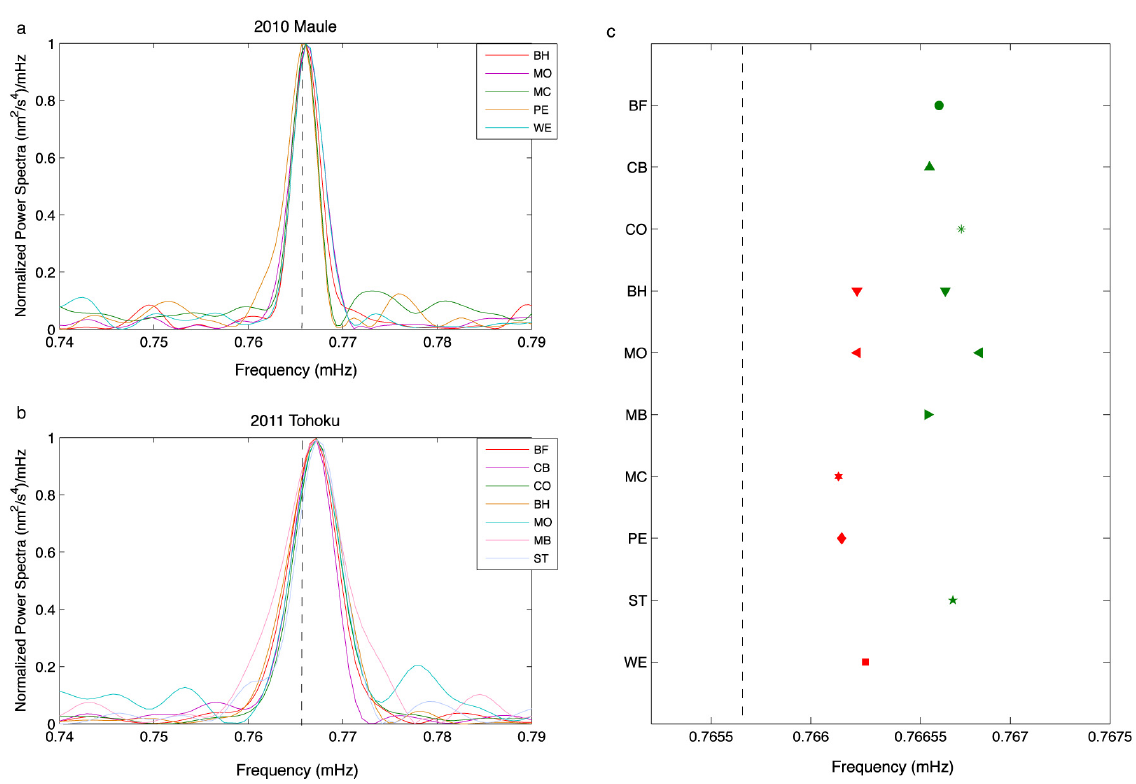
T . (a) The results of 5 residual gravity time series after the 2010 Maule event; (b) the results of 7 residual grav- Figure 10. The power spectra of 0 4 ity time series after the 2011 Tohoku; (c) the estimated frequencies from different series. The residual gravity time series after the 2010 event have a length of 120h, and the series after the 2011 event have a length of 80h. The PREM prediction is denoted by the vertical dashed